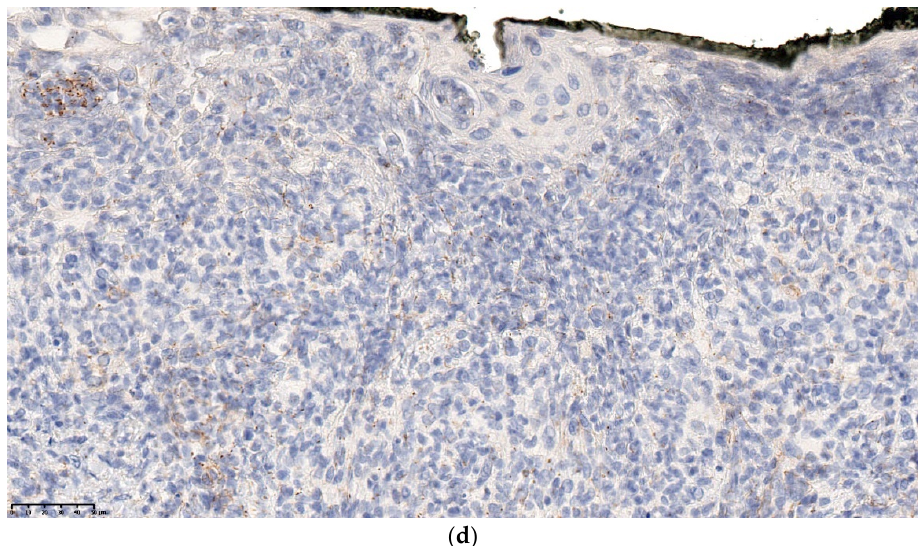
Figure 2. Congenital syphilis. ( a ) Multiple small erythematous lesions (by courtesy S Mallet). ( b ) 4× superficial and deep cellular infiltrate with ulcerated overlying epidermis (by courtesy N Macagno). ( c ) 25× polymorphic infiltrate containing plasma cells. ( d ) Positivity of anti-treponema showing numerous spirochetes between cells.